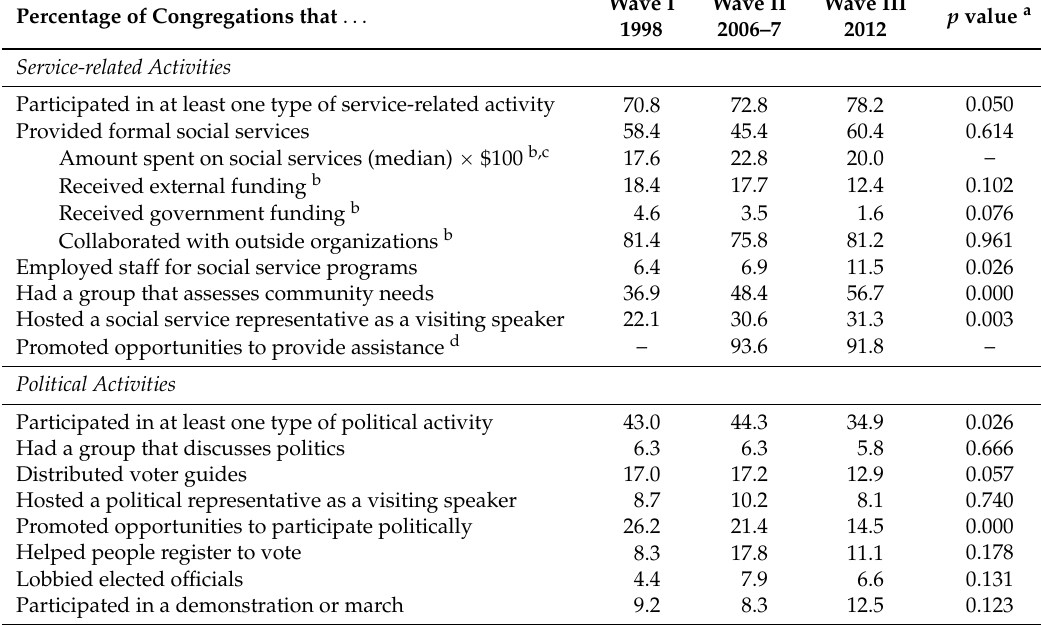
Table 1. The percentage of congregations involved in service-related and political activities for each